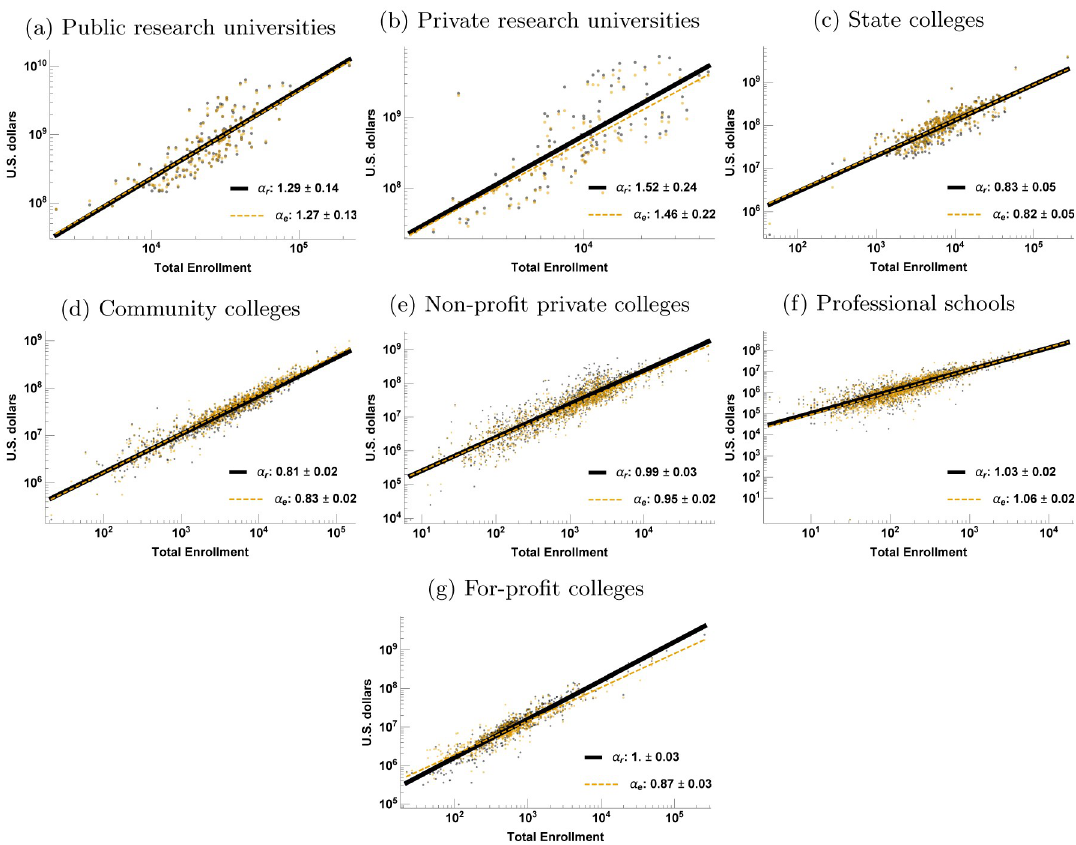
Fig 2. University sector scaling behavior. The scaling of total revenue (subscript “r”) and total expenditure (subscript “e”) as a function of total enrollment by sector. The regression lines may overlap, with expenditure hiding the revenue regression line.